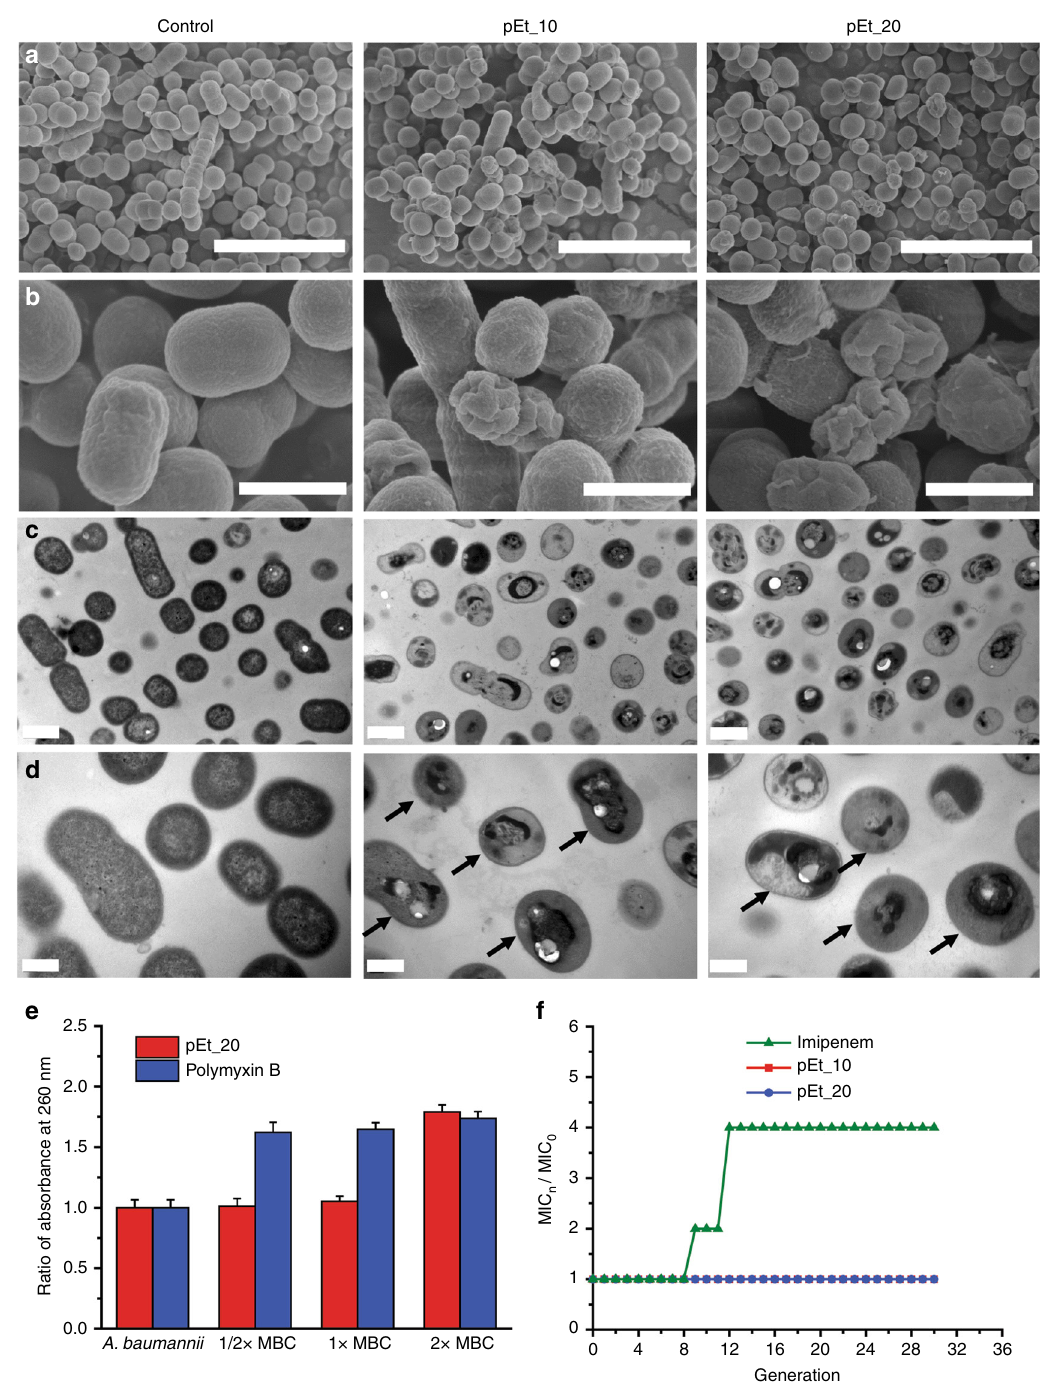
Fig. 4 Analyses of mechanisms of the antimicrobial polymers. Scanning electron microscopic (FE-SEM) ( a , b ) and transmission electron microscopic (TEM) ( c , d ) images of A . baumannii 10073 with and without polymer treatment. Treatment conditions: 4 × MIC, 2 h. Scale bar: SEM — 5 µ m in a and 1 µ m in b ; TEM — 1 µ m in c and 0.5 µ m in d . e Ratio of absorbance at 260 nm of supernatant in A . baumannii 10073 suspension treated with pEt_20 or polymyxin B for 2 h at different concentrations as speci fi ed (bacterial density: 2.08 × 10 9 CFU/mL). Ratios above 1.0 re fl ect release of cytoplasmic materials of